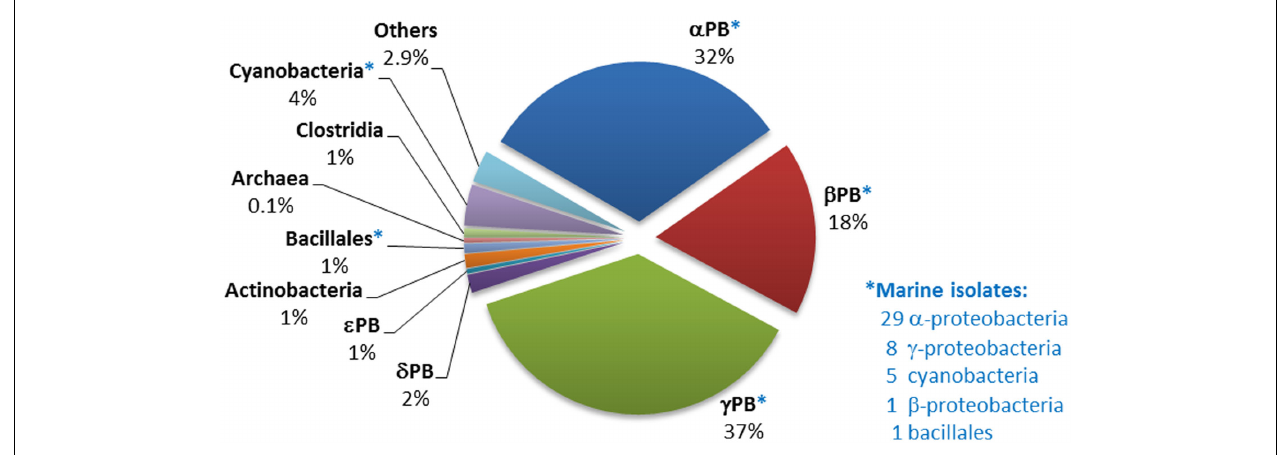
FIGURE 3 | Distribution of phnJ homologs within sequenced bacterial genomes. The numbers and affiliations of marine bacterial strains that contain